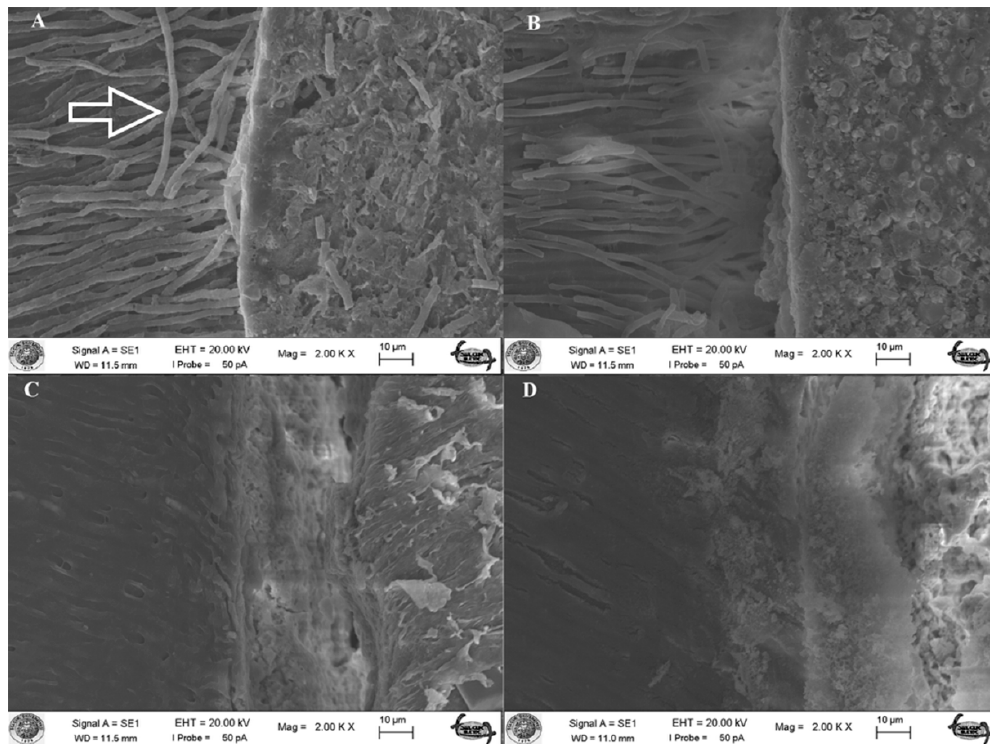
Figure 1. ( A ) Scanning electron micrograph (×2000) of a sample in group 1 (AH/CLC). Radicular dentinal wall is densely covered with AH Plus sealer and resin tags (indicated with an arrow) occluding the dentinal tubules; ( B ) Scanning electron micrograph (×2000) of a sample in group 3 (AH/C). Dentinal wall is partly covered with the sealer and tags protruding from the sealer; ( C ) Scanning electron micrograph (×2000) of a sample in group 2 (ES/CLC). The area is covered with the sealer but there is no visible sealer tags in dentinal tubules; ( D ) Scanning electron micrograph (×2000) of a sample in group 4 (ES/C) where there is almost debonding of the sealer from the radicular dentinal wall and no sign of tag elements.